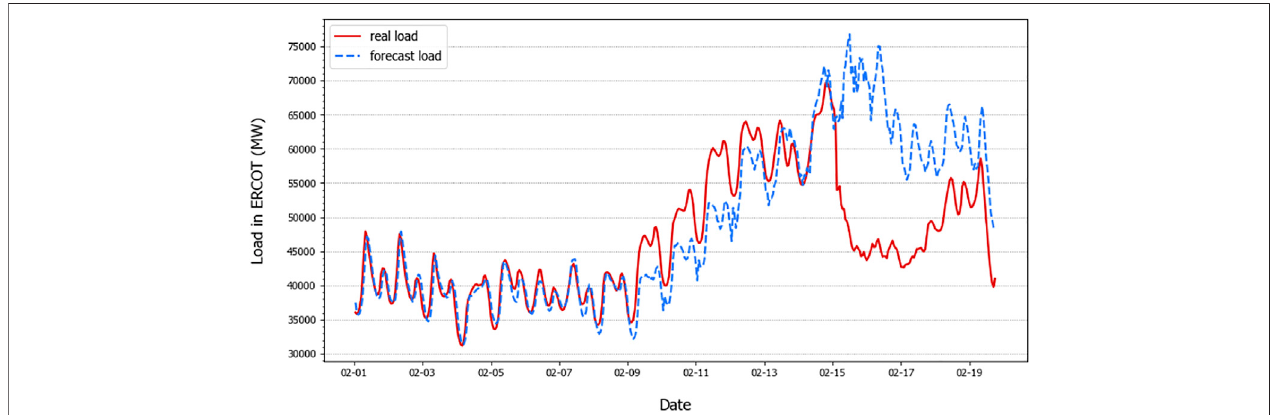
FIGURE 6 | Comparison of real and forecast load from February 1st to February 20th in 2021.